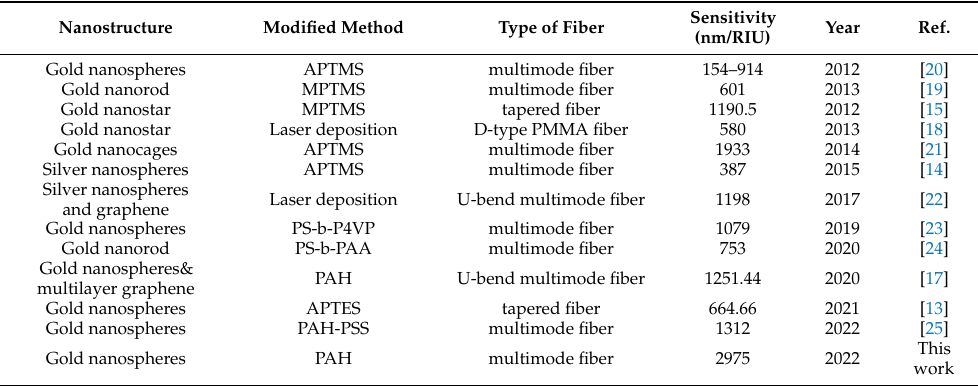
Table 3. Comparisons of SRI of LSPR fiber sensors by literature